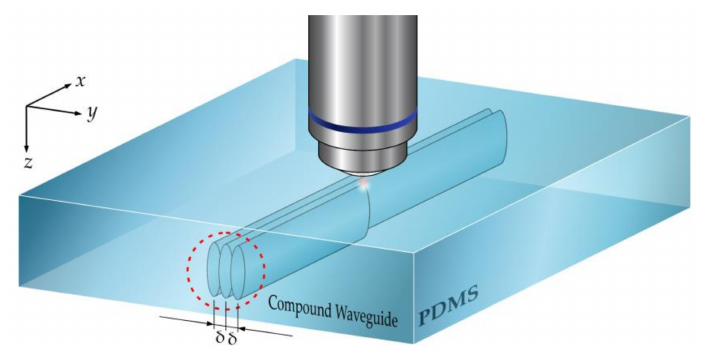
Figure 5. Schematic of the writing of compound waveguides. The PDMS sample is displaced by a small distance δ by means of a piezoelectric stage in the y direction. A long travel range mechanical stage moves the sample over centimeters in the